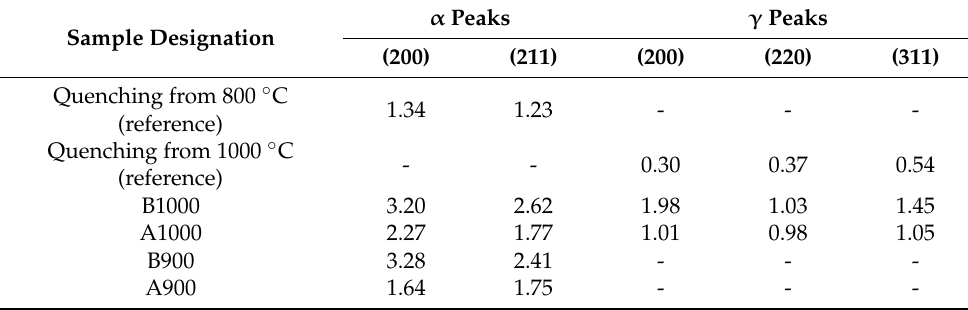
Table 2. FWHM, 2 Θ deg., for investigated